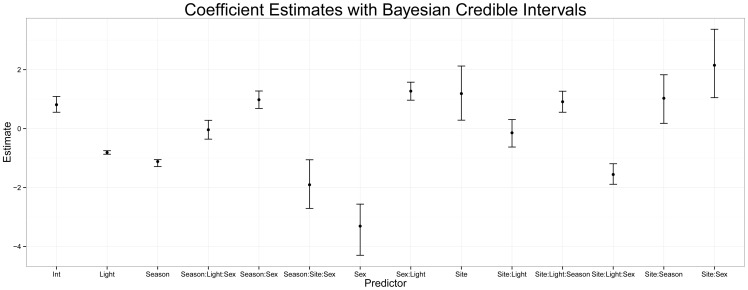
Beta coefficient estimates for predictor variables.